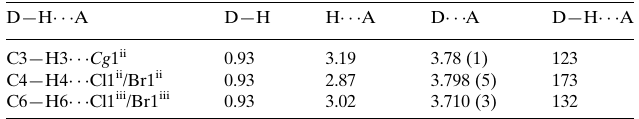
Hydrogen-bond geometry (A˚ , (cid:1)